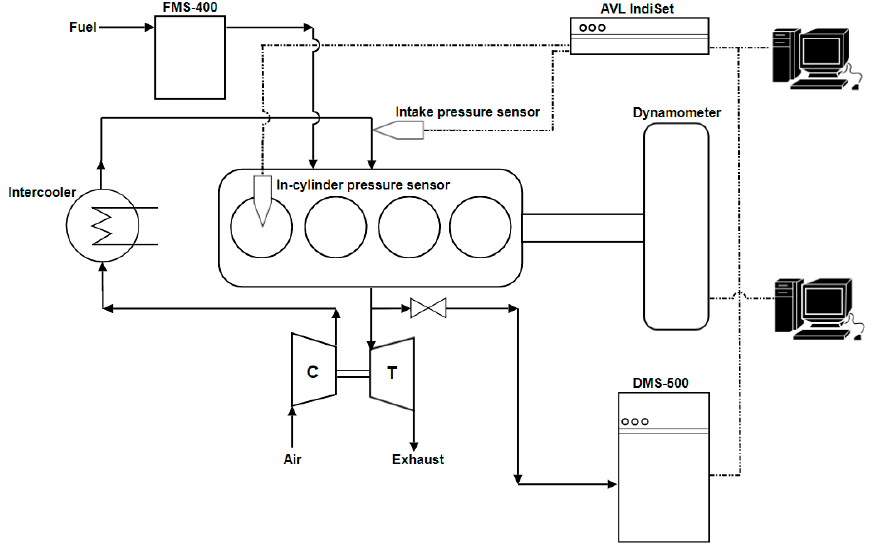
Figure 1. Schematic of the engine test-rig. Table 1. GDI test-engine specifications.